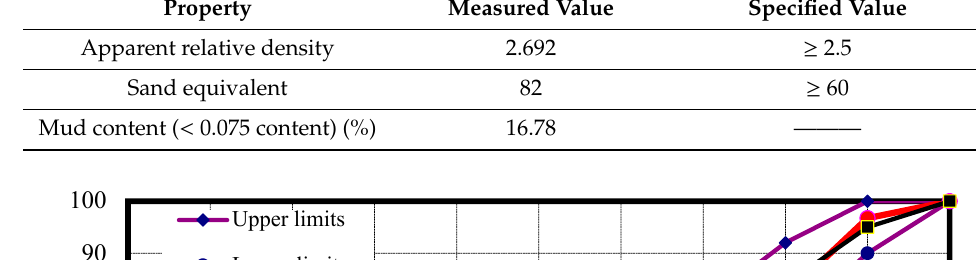
Table 3. Measured values of asphalt binder.